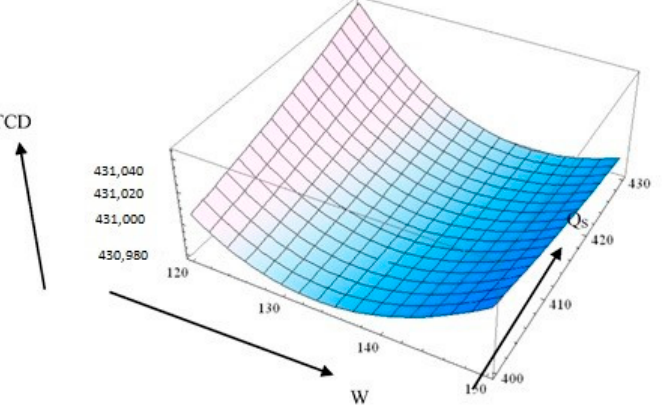
Figure 4. Convexity of TCD with respect to W and Q s .